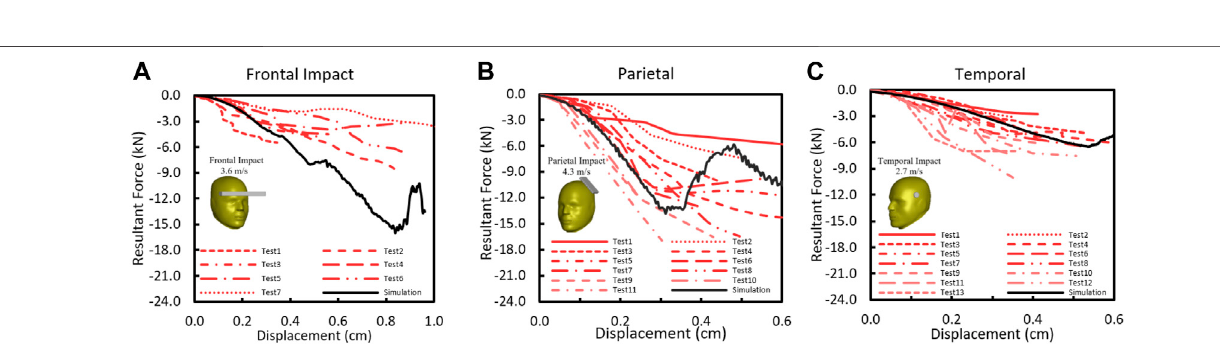
FIGURE 6 | Force – de fl ection responses between the model prediction and the experimentally measured results for (A) nasal bone, (B) zygomatic bone, and (C) maxilla.